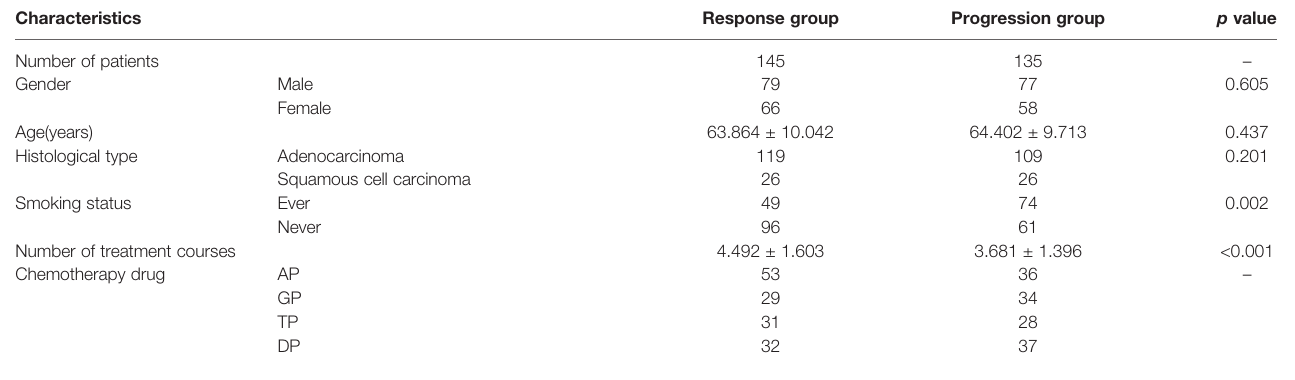
TABLE 2 | Clinical characteristics of NSCLC patients.